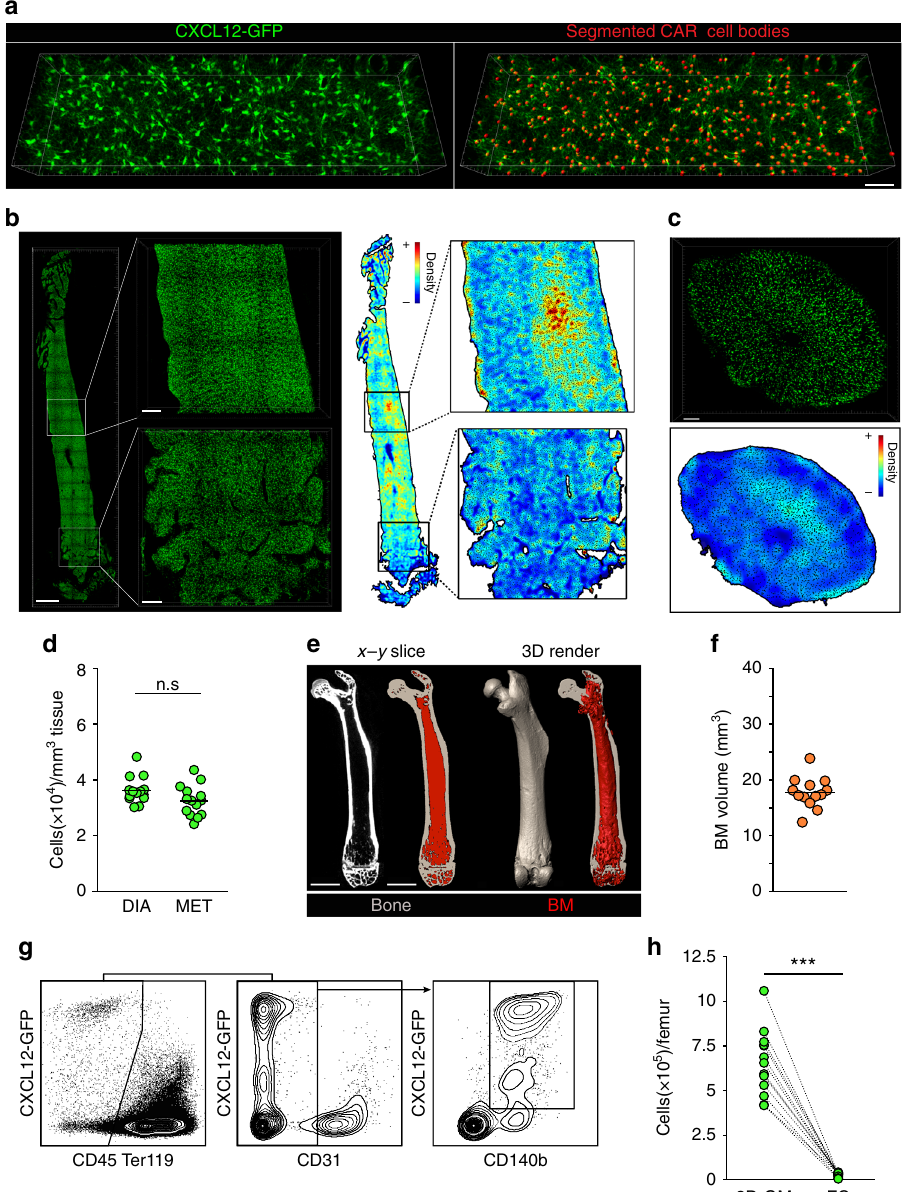
Fig. 2 3D-QM reveals signi fi cant underestimation of CARcs by FC-based methods. a Representative 3D image of a region from the femoral diaphysis showing the typical distribution and morphology of CARcs (left). Annotated image in which all CARc bodies are automatically detected using the Spots module of Imaris software (red spheres). Scale bar, 50 µ m. b Representative 3D images of CARcs (green) distribution in longitudinal slices of entire BM cavities (left; scale bar, 1 mm) diaphysis (top) and metaphysis (bottom; scale bars, 200 µ m). Colour-coded tissue density maps based on the detection and quanti fi cation of CARc presence are shown on the right. c Representative 3D image of a transversal slice of the femoral bone from a Cxcl12-Gfp mouse sectioned at the level of the diaphysis (top; scale bar, 100 µ m) and its corresponding tissue density map (bottom) created as in b . CARcs are shown in green. d Density of CARcs in diaphysis (DIA) and metaphysis (MET) expressed as cells per mm 3 of BM tissue ( n = 14). The tissue volume visualized and quanti fi ed for CARc presence was 0.17 ± 0.03 µ L/femur. e Determination of absolute BM volume contained in single femoral bones using µ -CT. Raw images of 2D cross-sections are processed to segment BM (red) and bone (grey; left). Scale bar, 2 mm. A 3D rendering of the entire femur is shown here where the extracted total marrow volume is visible (right). f Quanti fi cation by µ -CT of BM tissue volumes contained in the femurs from Cxcl12-Gfp mice ( n = 13). g Representative FC dot plots and the employed gating strategy for the quanti fi cation of CARc frequencies and absolute numbers after enzymatic tissue processing into cell suspensions. h Pairwise comparisons of total CARc numbers as enumerated by 3D-QM and FC. Lines connect dots corresponding to contralateral femurs of the same individual mice ( n = 12). For 3D-QM, individual dots correspond to values obtained from calculating the weighted average of two images from different BM regions. Signi fi cance was analysed using the Mann – Whitney test *** P < 0.0001; n.s. not signi fi cant with P < 0.01. In d , f bars show the mean and dots represent data from single femurs from different